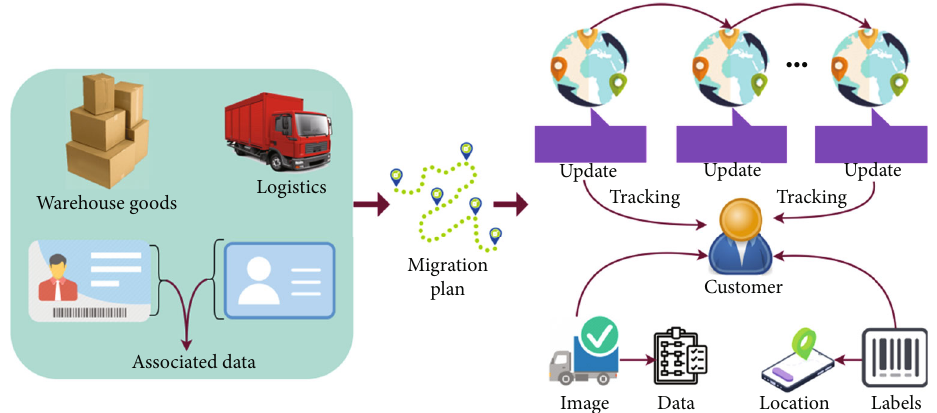
Figure 2: Migration process and data